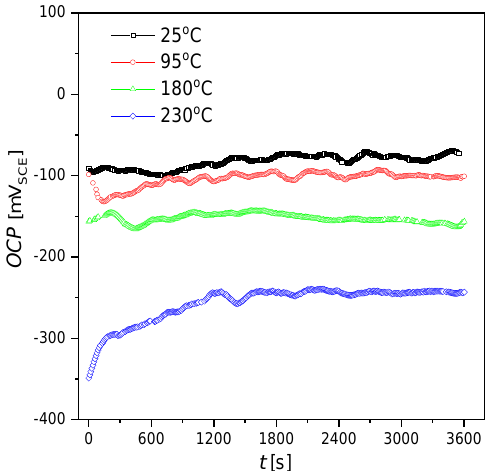
Figure 1. Open circuit potential for the AISI 1010 steel electrodes immersed in sulfolane at 25, 95, 180, and 230 ◦ C; V SCE is the electrode potential measured versus saturated calomel electrode. Table 1. Average value of open circuit potential ( OCP av ) and corresponding standard error ( SE) determined for the AISI 1010 steel electrodes immersed in sulfolane at 25, 95, 180, and 230 °C; V SCE is the electrode potential measured versus saturated calomel electrode.